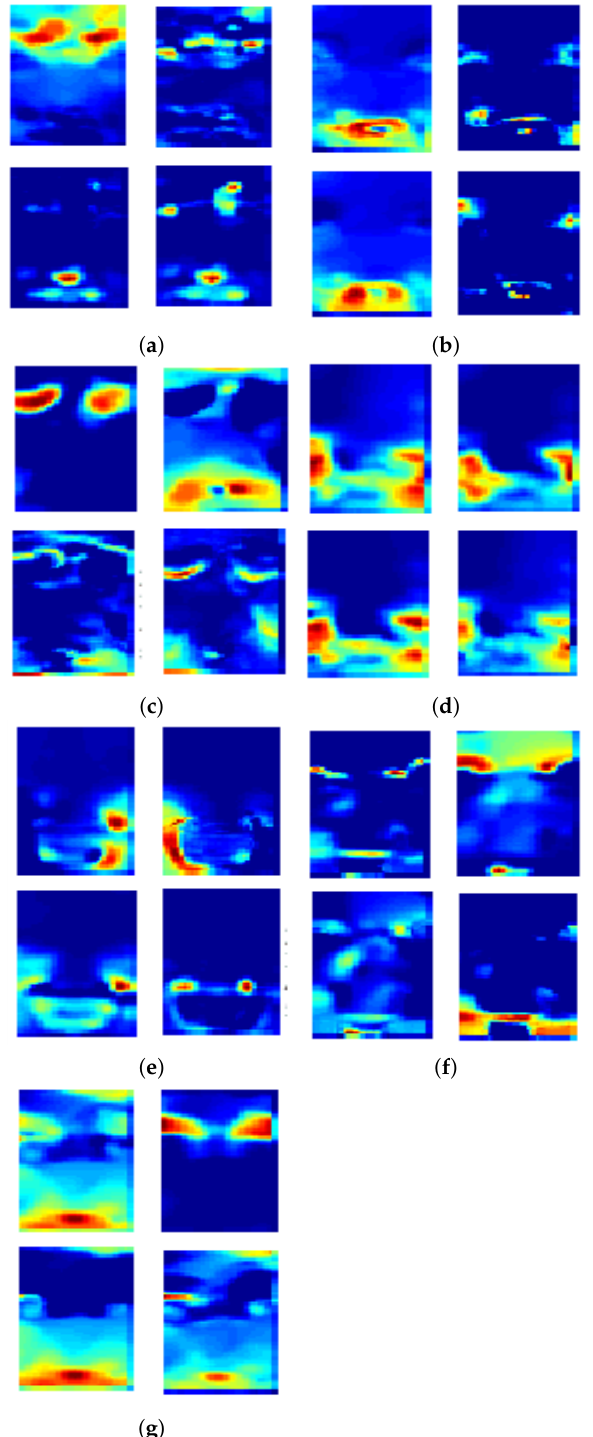
Figure 6. Examples of dense motion flow of different facial expressions. Optical flow is color-coded by its direction and intensity. ( a ) Anger, ( b ) Contempt, ( c ) Disgust, ( d ) Fear, ( e ) Happiness, ( f ) Sadness, ( g )